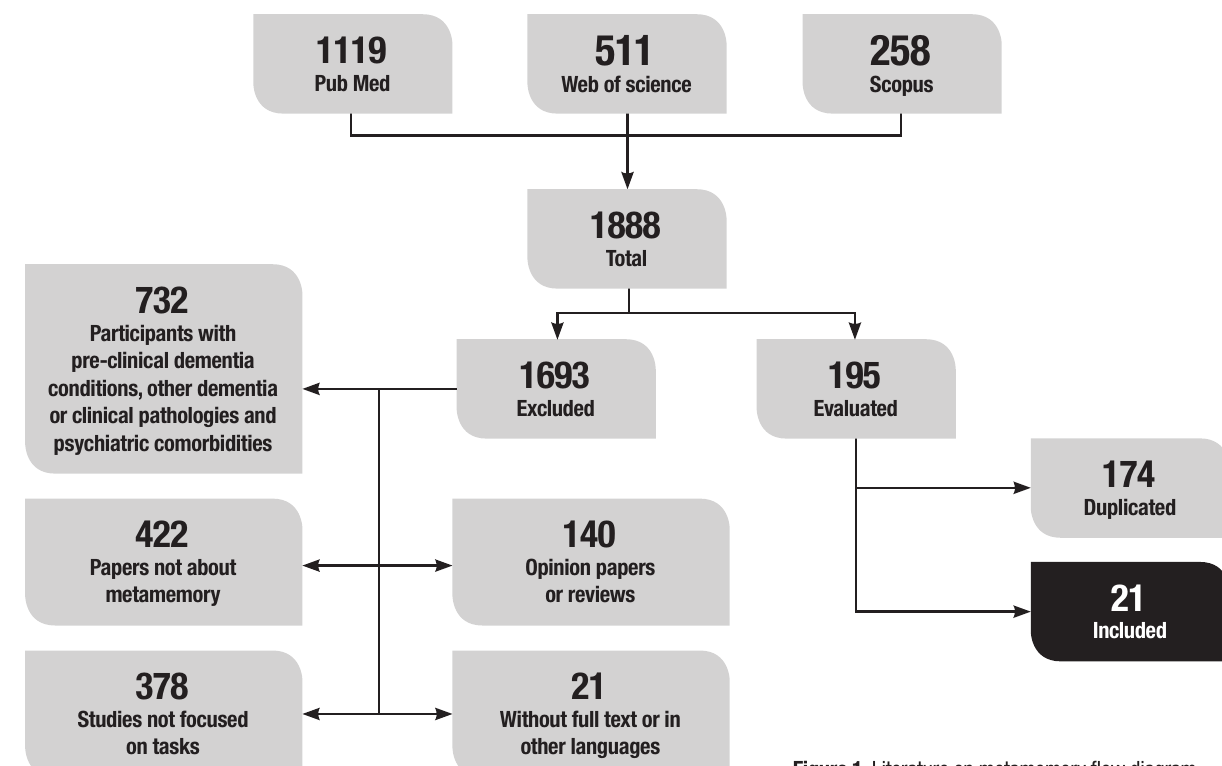
Figure 1. Literature on metamemory flow